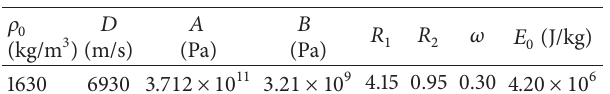
Table 4: Parameters in Jones-Wilkins-Lee (JWL) EOS for explosive gas [24].